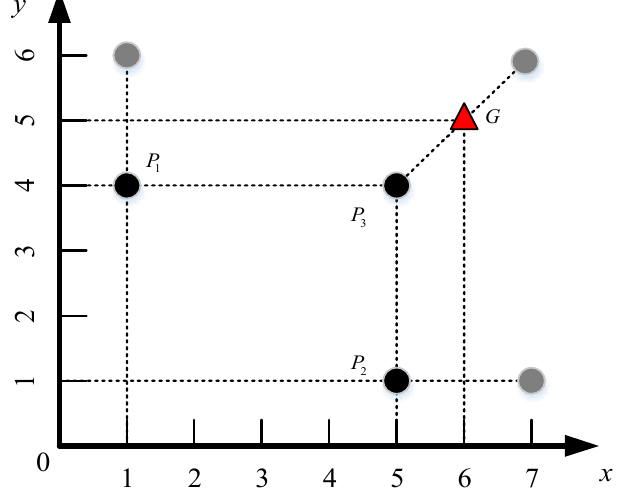
Figure 2. Two-dimensional schematic diagram of selective leading opposition .